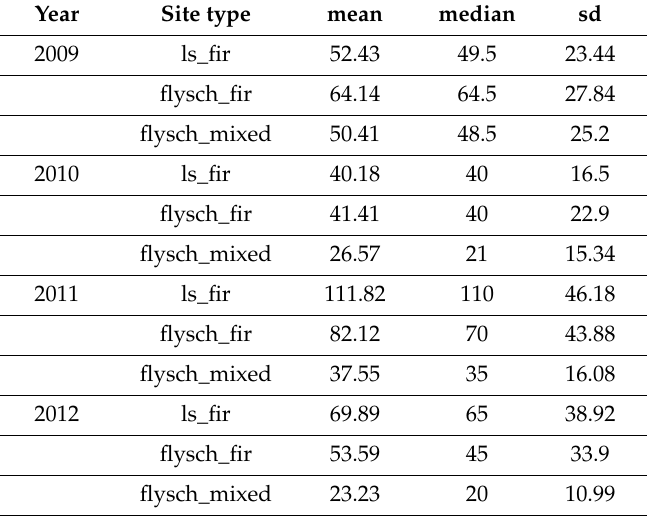
Table 2. Annual growth (mm) of seedlings surviving in Autumn 2012 (total n = 286).